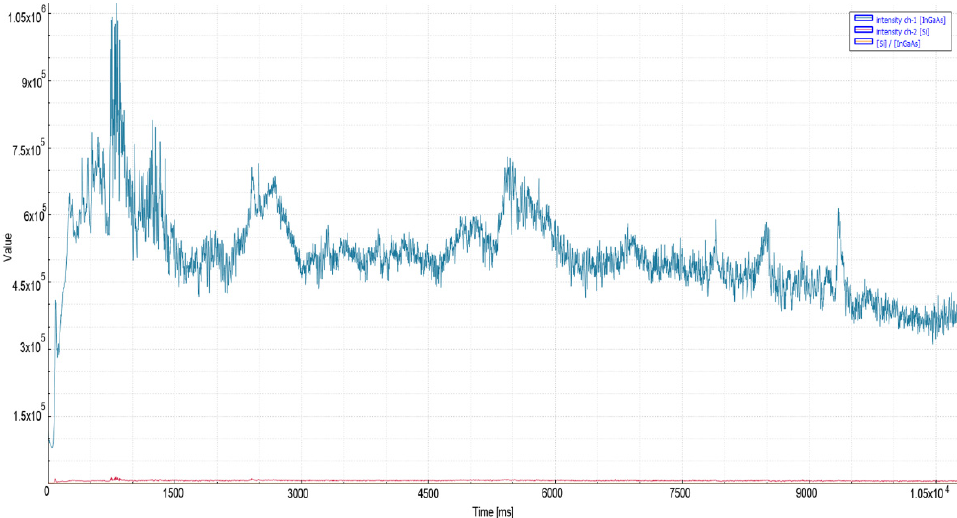
Figure 7. Measurement values recorded during oxygen cutting of 20 mm mild steel material.